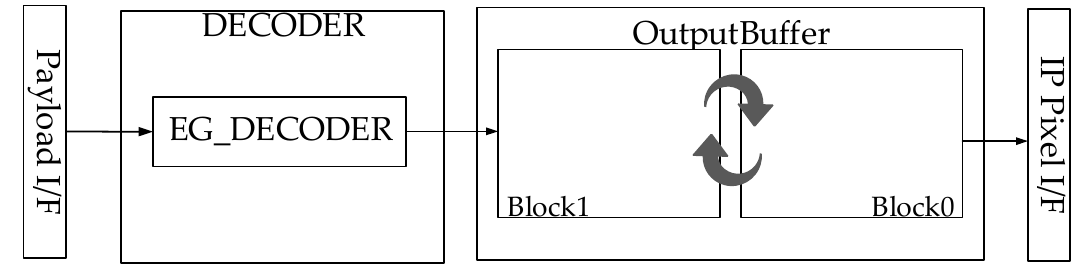
Figure 9. Proposed LEC decompression engine.